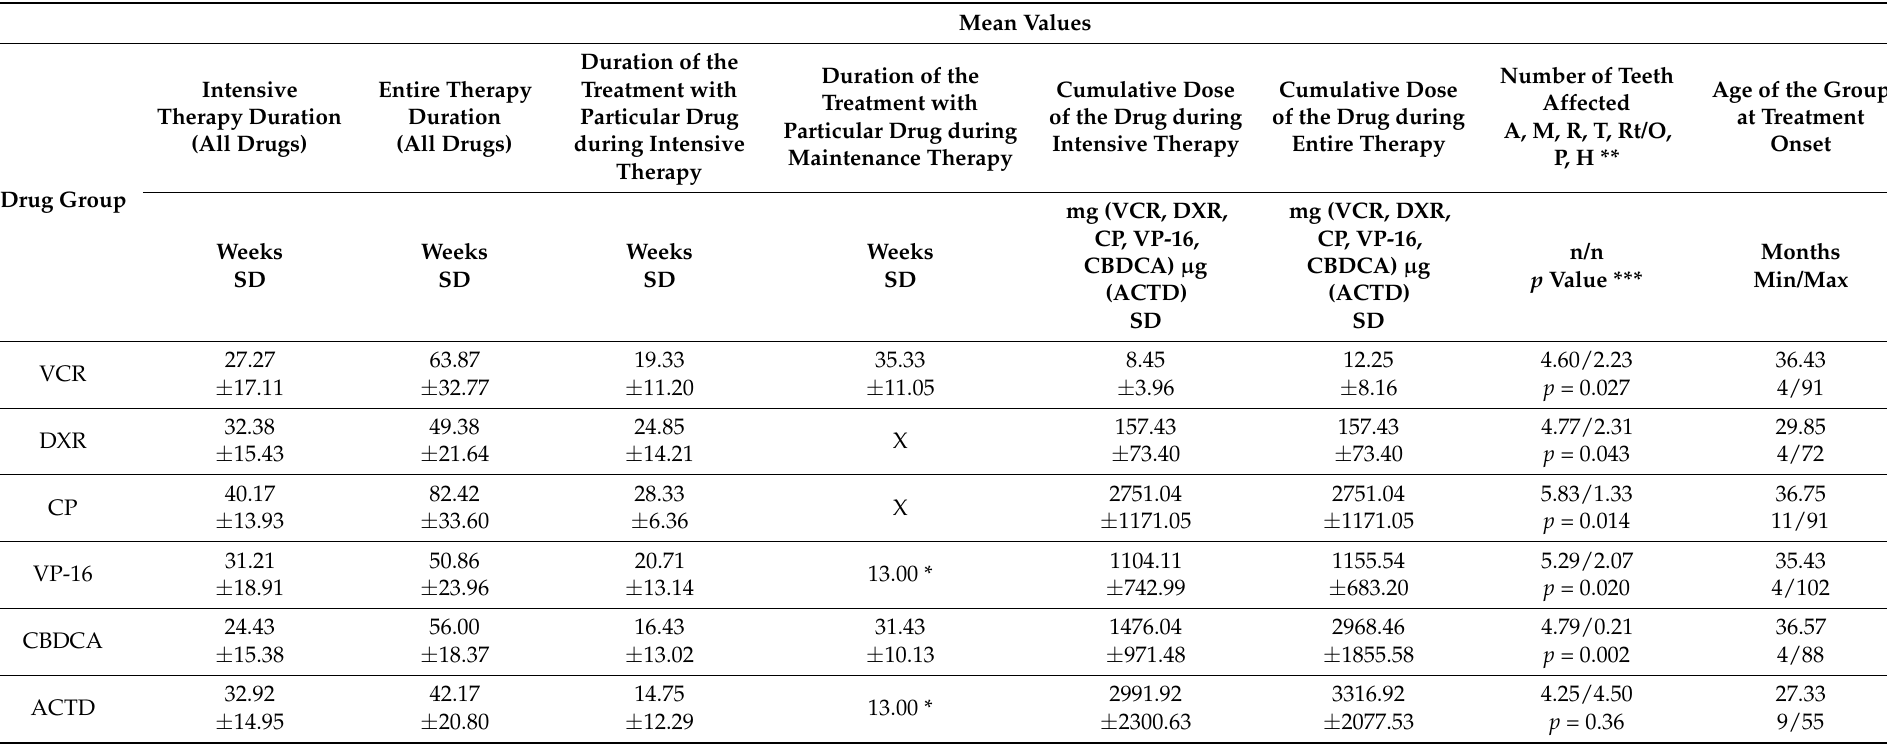
Table 2. Treatment duration and drug doses in relation to number of teeth affected and age at diagnosis.